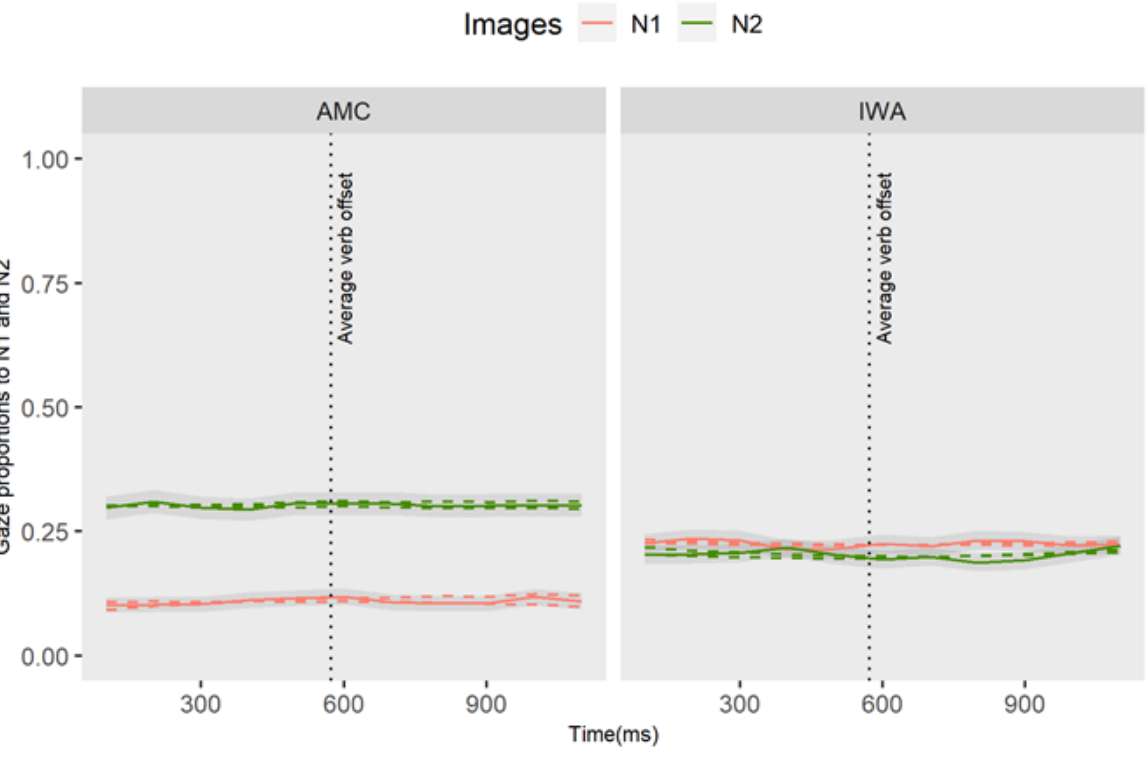
Figure A2. Gaze proportion differences to N1 and N2 between groups. Solid lines represent observed data and dashed lines represent the GCA model fit.